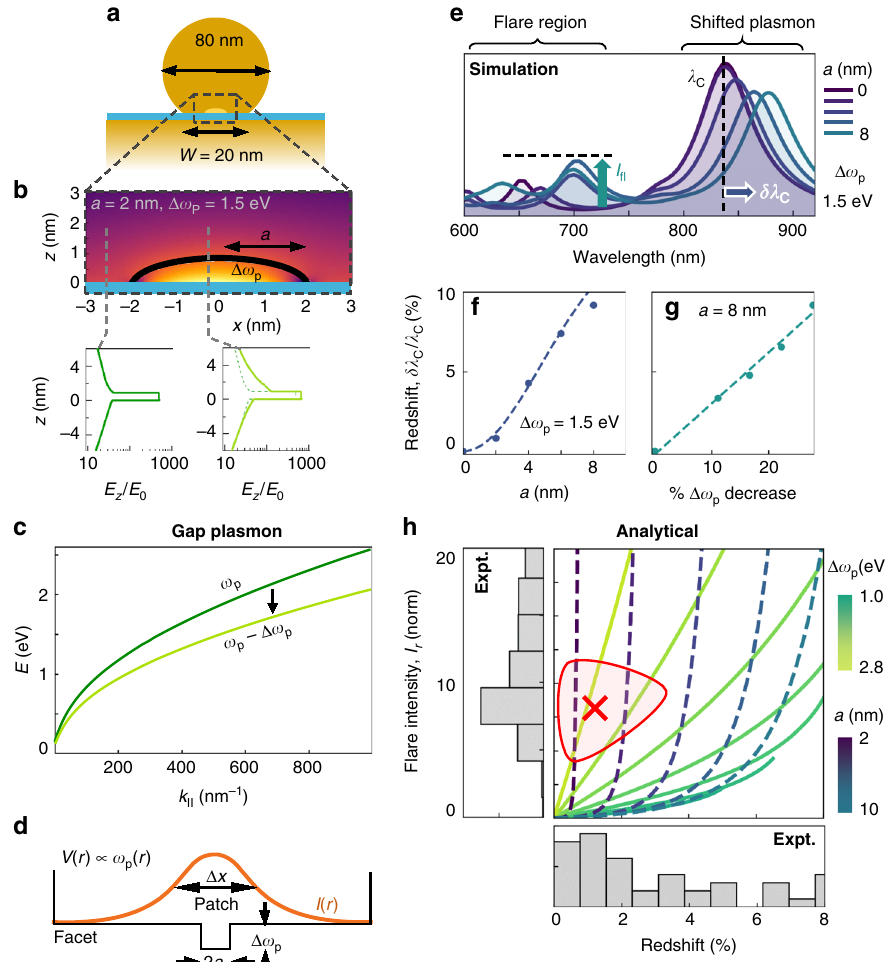
Fig. 3 Simulation of fl ares. a BEM simulation geometry (details in SI) with ( b ) region of defect patch of lower ω p and radius a (bounded by black line) giving optical fi eld inside patch at coupled mode resonance λ C ( E z slices across gap inside & outside the patch shown below). c Dispersion relation for gap plasmon with 20% reduction in local ω p . d Analytic model for defect, reducing the effective ω p within a central patch of the nanoparticle facet. I(r) is intensity of the coupled mode in the gap. e Simulated scattering cross section for decrease Δ ω p = 1.5 eV and a = 0 – 8 nm, showing fl are intensity I mode redshift δλ C . f, g Simulated (points) and analytical (dashed lines) coupled mode redshifts vs . a and Δ ω p , showing their agreement. h Analytical model for relative fl are intensity vs. mode redshift for (dashed) a = 2, 4, 6, 8, 10 nm over Δ ω p = 0 – 3.5 eV and (solid) Δ ω p = 1, 1.3, 1.6, 1.9, 2.2, 2.5, 2.8 eV over a = 0 – 15 nm. Grey histograms show experimental measurements of fl are intensity (left) and λ C mode redshift (bottom). Red marker shows